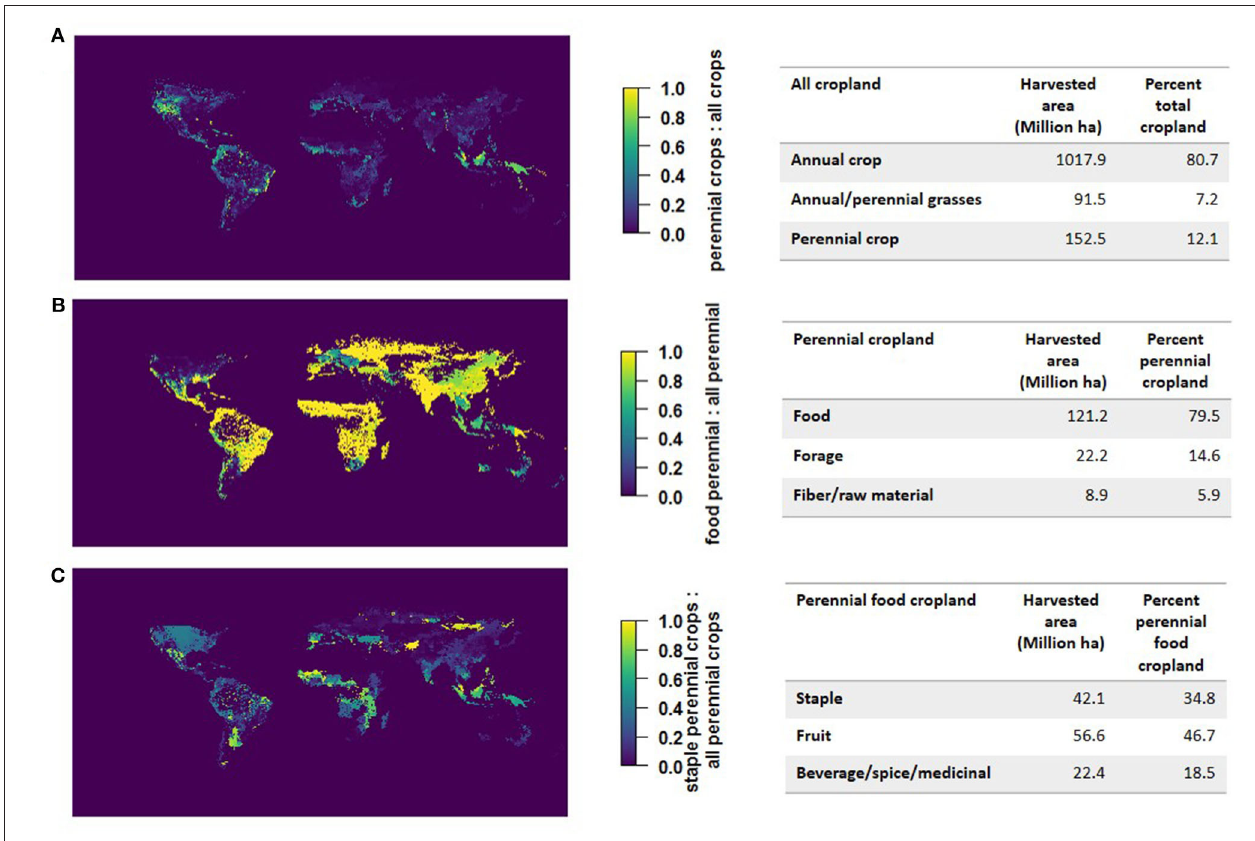
FIGURE 2 | Land in perennial production. (A) Perennial cropland as a ratio of total cropland. (B) Food-producing perennial cropland as a ratio of total perennial cropland. (C) Staple crop producing perennial cropland as a ratio of total food-producing perennial cropland. Data categorized and re-analyzed from EarthStat database ( Monfreda et al., 2008). Figures and table results were produced in R using the raster, rasterVis, and maps